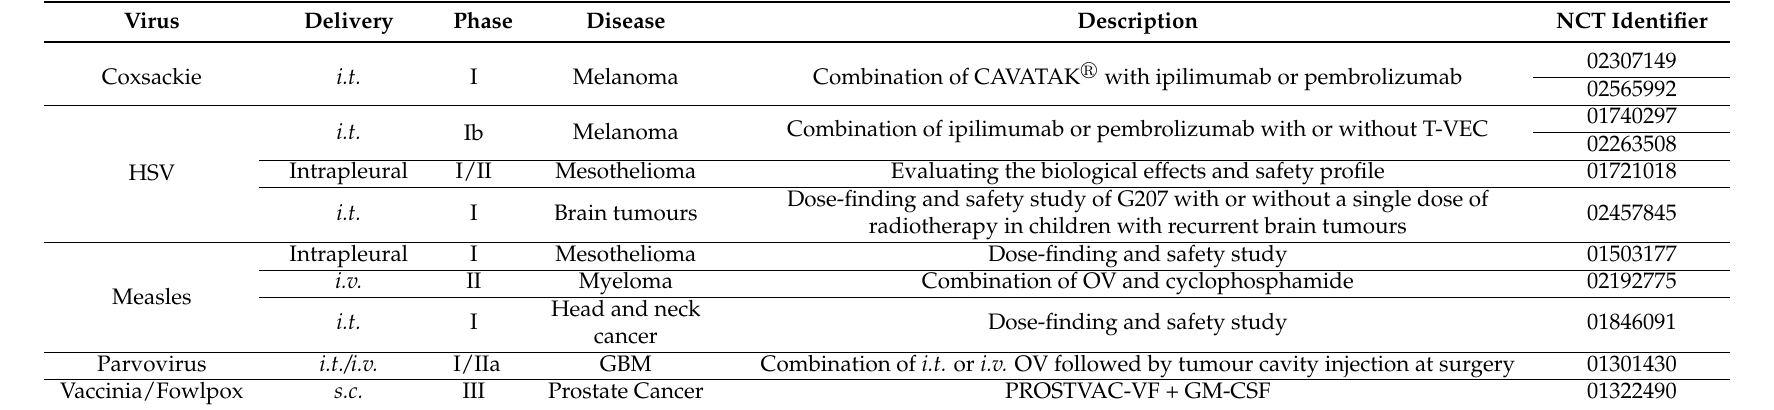
Table 2. A selection of currently open clinical trials registered with the national cancer